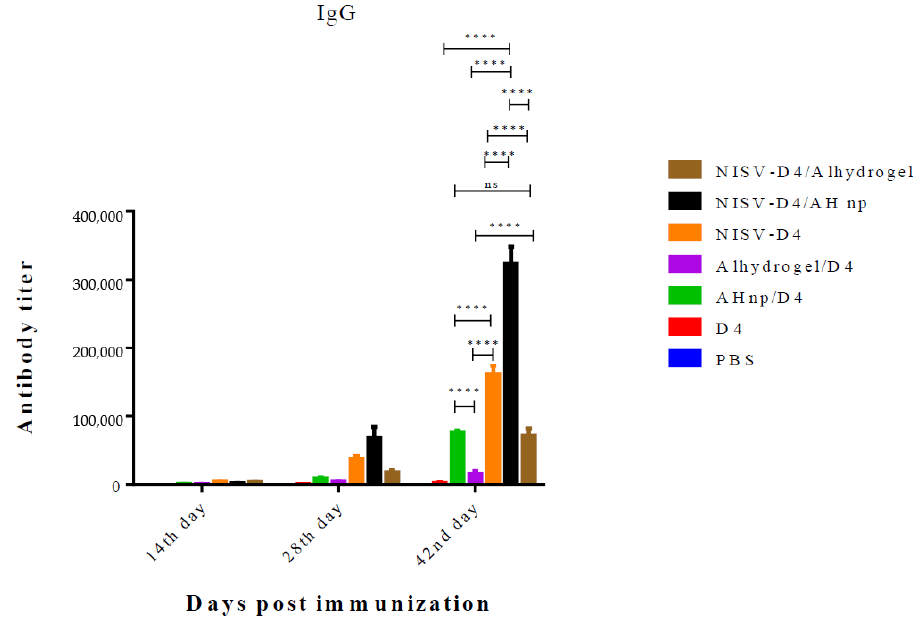
Figure 2. Anti-D4 IgG titres elicited by Swiss albino mice immunised via intraperitoneal (i.p.) route with PBS, D4 only, AH np / D4, alhydrogel / D4, NISV-D4, NISV-D4 / alhydrogel, and NISVD4 / AH